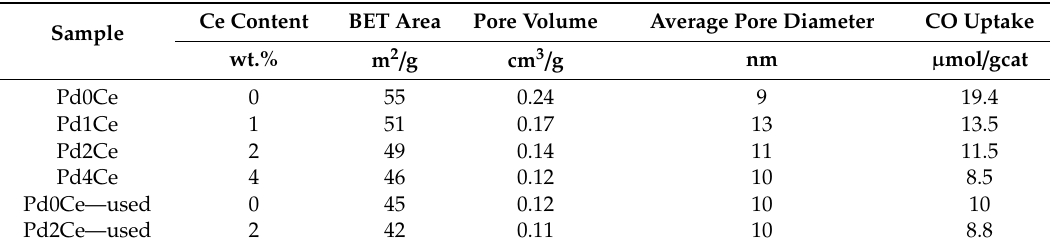
Table 1. Textural properties and CO uptake of PdO / CeO 2 / γ -AlOOH / γ -Al 2 O 3 monolith catalysts with varying Ce content.